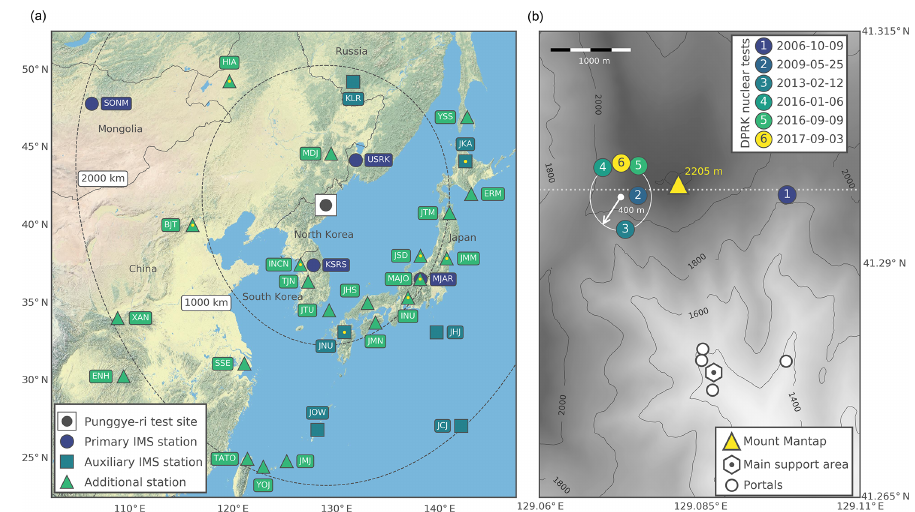
Figure 1. (a) Seismic stations of the International Monitoring System and other earthquake monitoring networks within a radius of 2100km from the North Korean Punggye-ri nuclear test site. Stations that are used in the moment tensor analysis in Sect. 2.3 are marked with a small yellow dot. (b) Zoom into the Punggye-ri test site area. Numbered circles indicate the absolute locations of the six North Korean nuclear tests. The relative location error for each test is less than 100m. The dashed line marks the profile used in Sect. 2.5 to study topographic influence of the Mt. Mantap on seismic energy generation and radiation from the